Question: Condense the content of this figure into a single sentence.
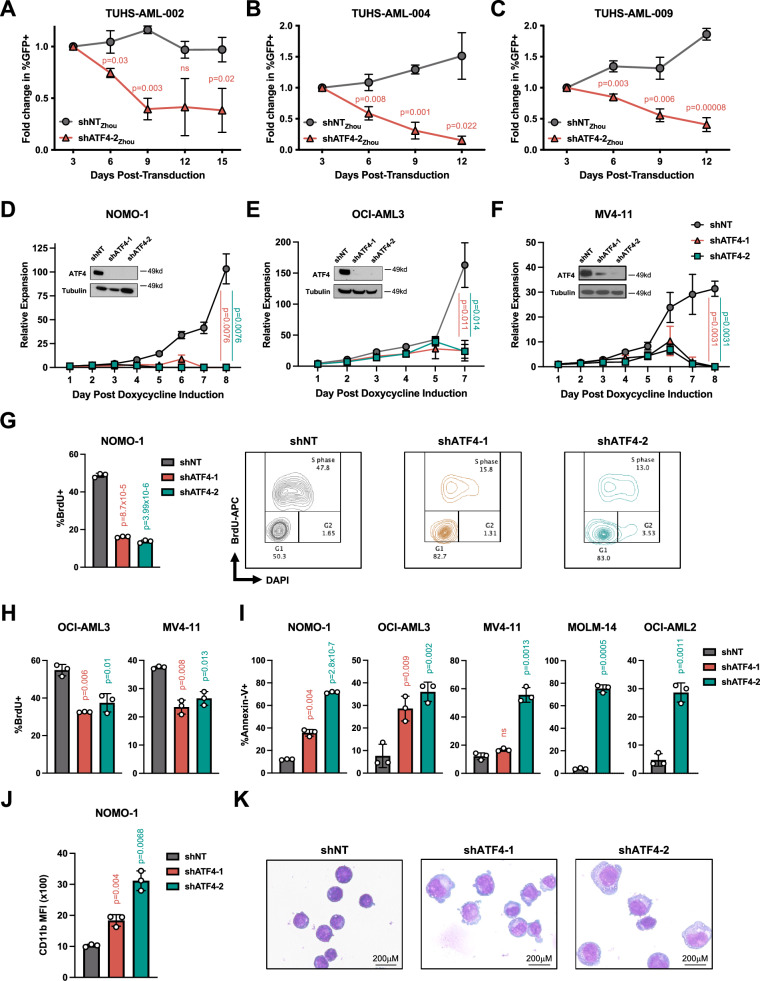
Answer: ATF4 supports AML cell cycling and survival. A – C Cryopreserved patient-derived samples were transduced with lentiviruses co-expressing GFP and shNT or shATF4 and then monitored for changes in %GFP by flow cytometry over the indicated time points post-transduction. Data represent the mean ± SD of three technical replicates from a single biological replicate performed per patient sample. Statistics are derived from a two-sided, unpaired t -test using Welch’s correction (95% CI) comparing the shNT control and shATF4-2 Zhou conditions at each time point. Multiple comparisons were carried out using a two-stage linear Benjamini–Krieger–Yekutieli (BKY) procedure (exact p- and q- values are listed in Source Data File). D – F NOMO-1 ( D ), OCI-AML3 ( E ), and MV4-11 ( F ) cells expressing DOX-inducible shNT, shATF4-1, or shATF4-2 were administered DOX and then analyzed for proliferation using an MTS assay at the indicated time points. Data are plotted as the fold change in MTS signal at each time point relative to that prior to DOX treatment. Inset, western blot analysis of ATF4 protein expression at 24 (NOMO-1 and MV4-11) or 48 h (OCI-AML3) post-DOX. For panels D – F , data represent the mean ± SD of three technical replicates. Each experiment was repeated in three independent, biological replicates. Statistics are derived from a two-sided, unpaired t -test using Welch’s correction (95% CI) comparing the shNT control with the shATF4-1 (pink p -values) or shATF4-2 (teal p -values) conditions. Multiple comparisons were carried out using a two-stage linear BKY procedure (exact p- and q- values are listed in Source Data File). G DOX-induced NOMO-1 cells expressing shNT, shATF4-1, or shATF4-2 were assessed for BrdU incorporation and DNA content by flow cytometry. Left , histogram analysis of flow data acquired using the contour plots presented to the Right . H Percentage of S-phase (i.e., BrdU+) of OCI-AML3 ( left ) and MV4-11 ( right ) for each shRNA condition. I NOMO-1 ( far